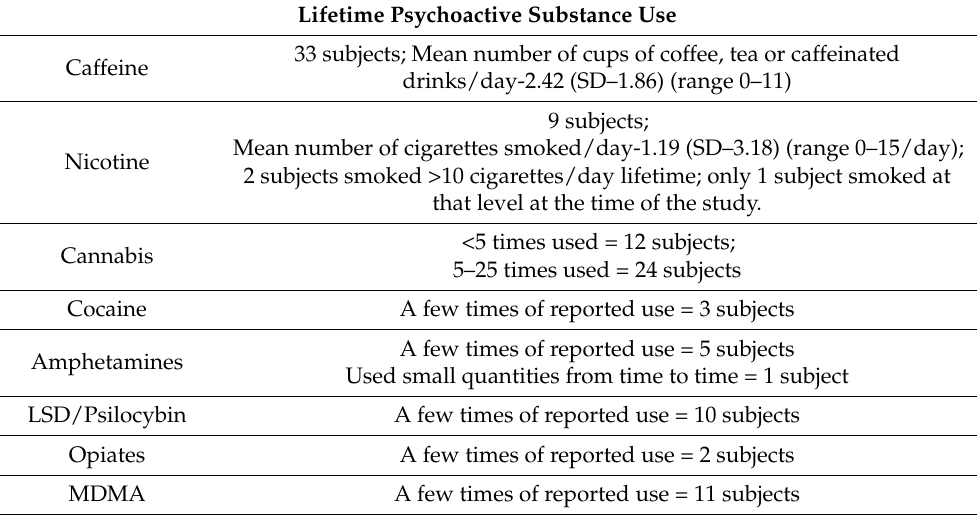
Table 1. Previous use of psychoactive substances by participants (amended from our previous publication